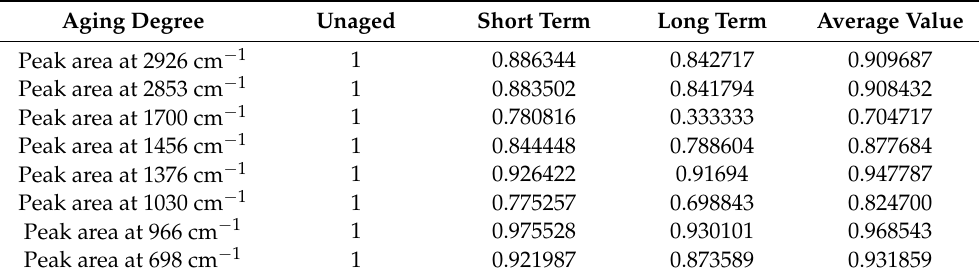
Table 9. Grey correlation degree between CT Index and different peak areas (LFSMA-13).